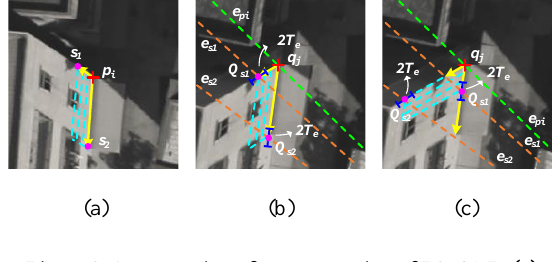
Figure 6. Computation of support region of EG-SAF. (a) support region of interest point on source image, (b) a case of support region of candidate point on target image, and (c) another case of support region of candidate point on target